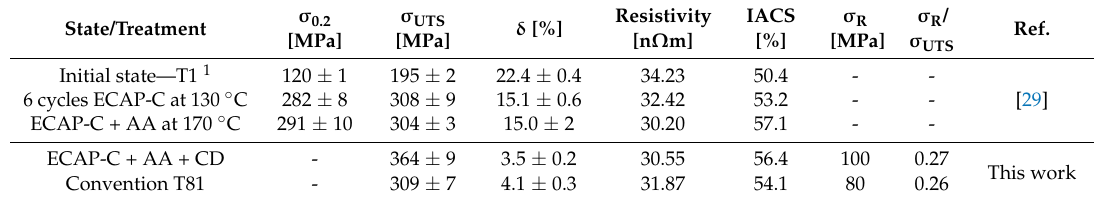
Table 2. Mechanical properties and electrical conductivity of the Al 61 01 alloy during processing.